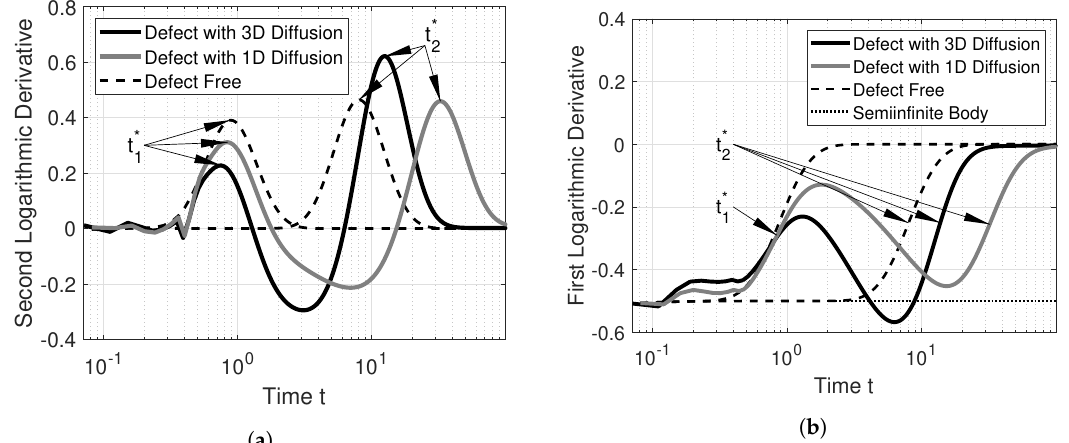
Figure 4. Interpreting the characteristic times: ( a ) second logarithmic derivative and ( b ) the first logarithmic derivative of simulation